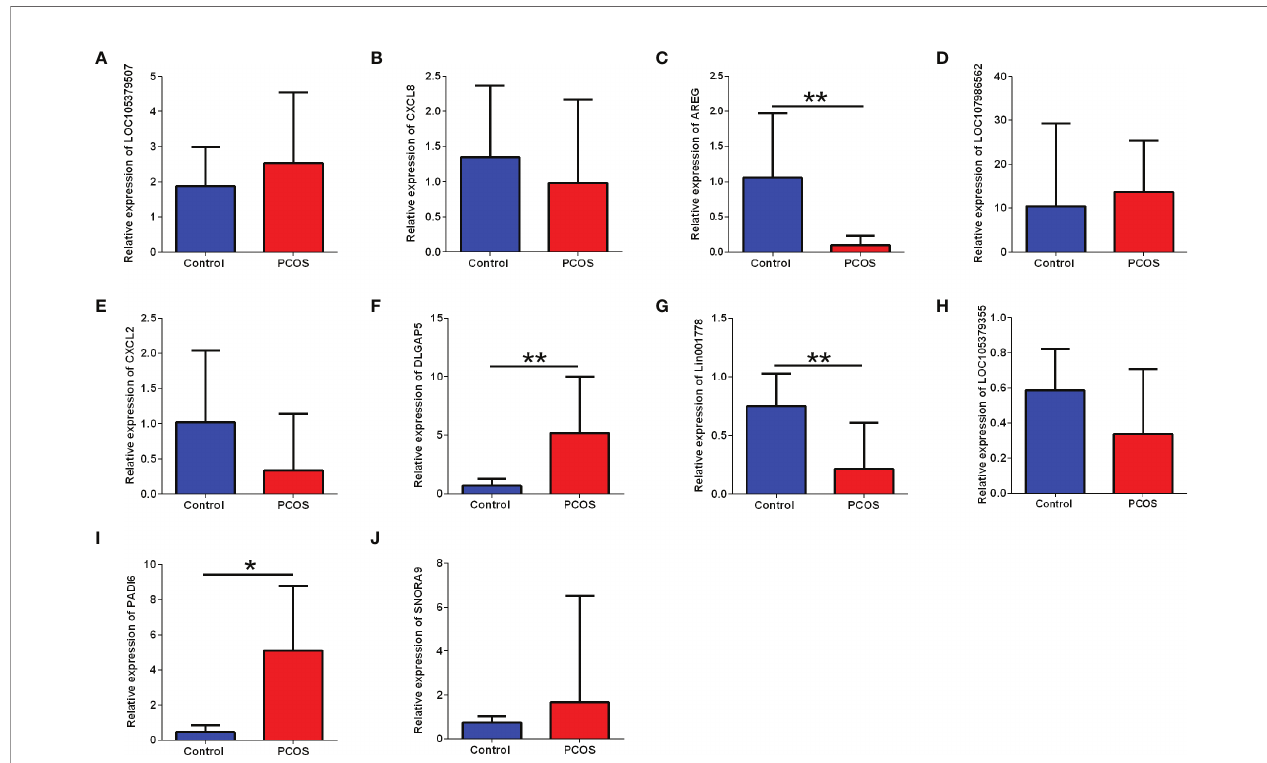
FIGURE 4 | Validation analysis of selected differentially expressed candidate genes between control group and PCOS group. The mRNA expression levels of (A) LOC105379507, (B) CXCL8, (C) AREG, (D) LOC107986562, (E) CXCL2, (F) DLGAP5, (G) Lin001778, (H) LOC105379355, (I) PADI6, and (J) SNRA9 in the ovarian tissues between control group and PCOS group. N = 8 – 11. *P < 0.05 and **P <